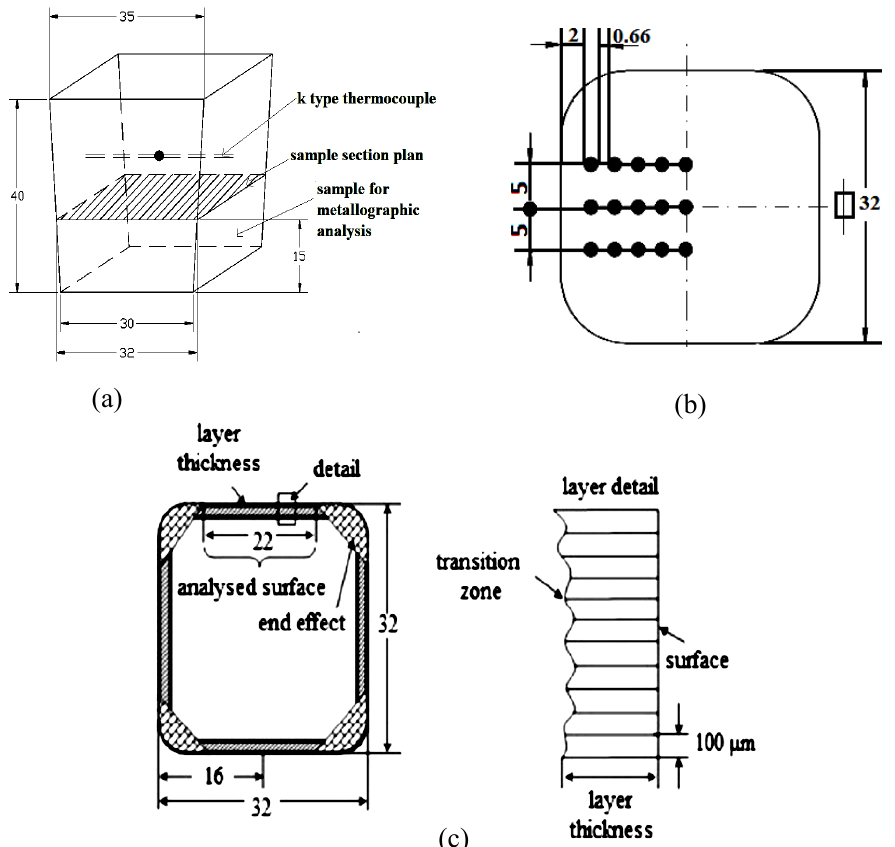
Figure 1. Metallographic sample drawn ( a ), analysis points on the sample section ( b ) and surface layer thickness ( c ) evaluation [15].